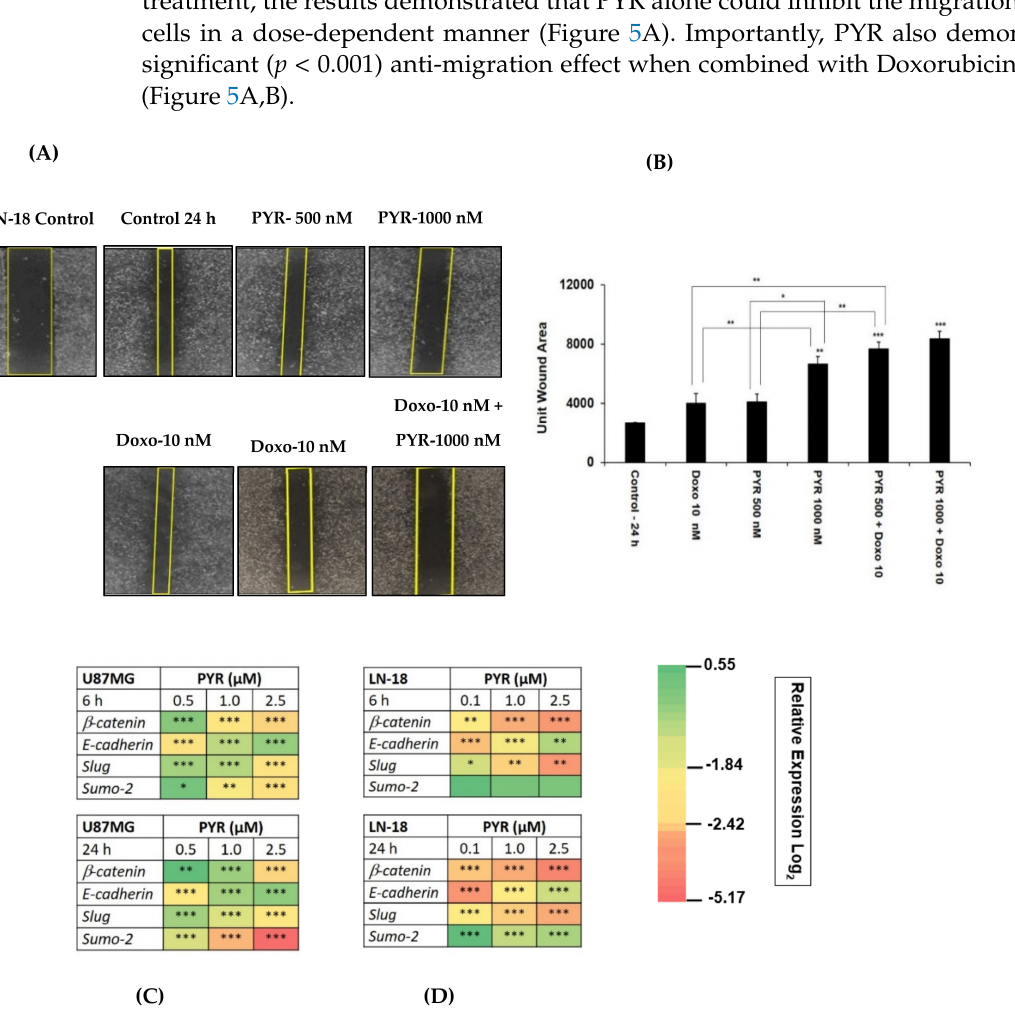
Figure 5. ( A ) A wound healing assay representing the effect of PYR (500 nM and 1000 nM) alone and in combination with Doxo (10 nM) on migration and invasive potential of LN-18 cells 24 h post addition of compounds. ( B ) Bar graphs show wound closure quantified by Image J software. ( C , D ) Heatmap